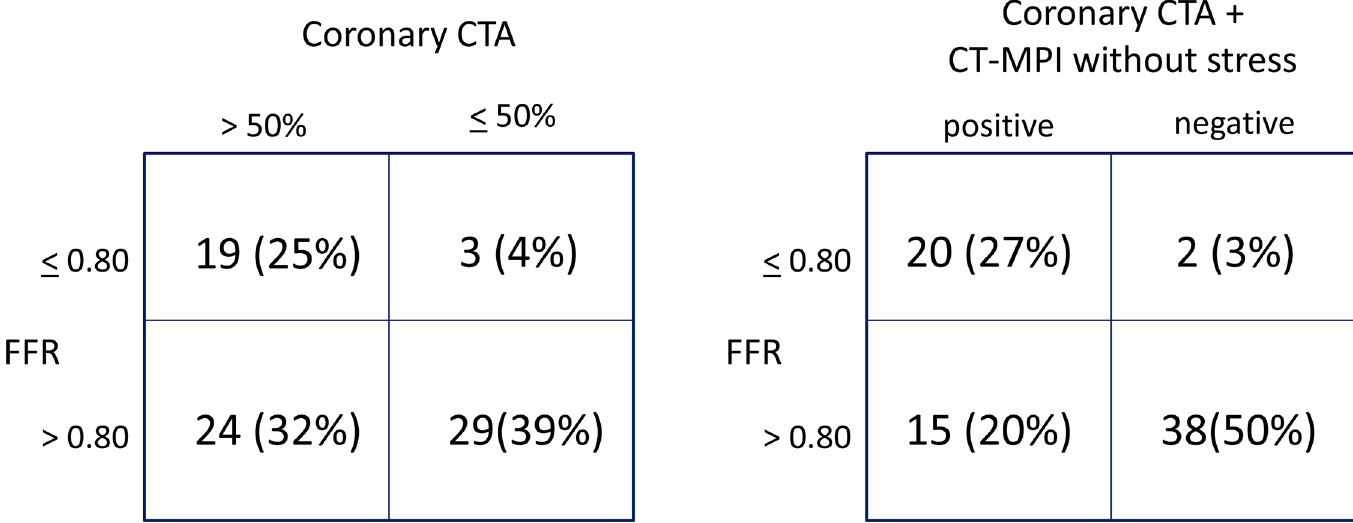
Fig 3. Agreement for detection of ischemia (FFR (cid:3) 0.80) between CCTA and CCTA + CT-MPI without stress on a per-vessel basis. Data given as number (%); n = 75 vessels.